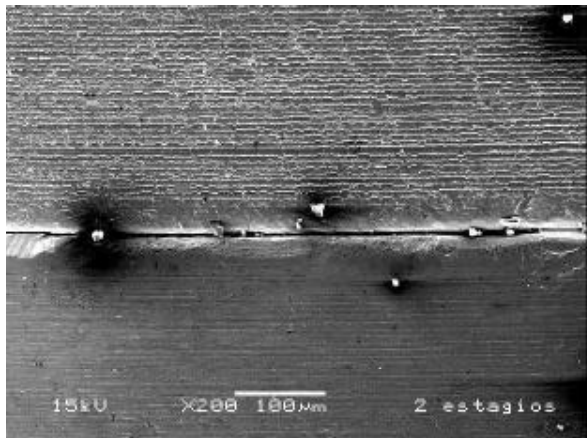
FIGURA 13- Determinação da extensão da fenda (seta) no sistema de um estágio